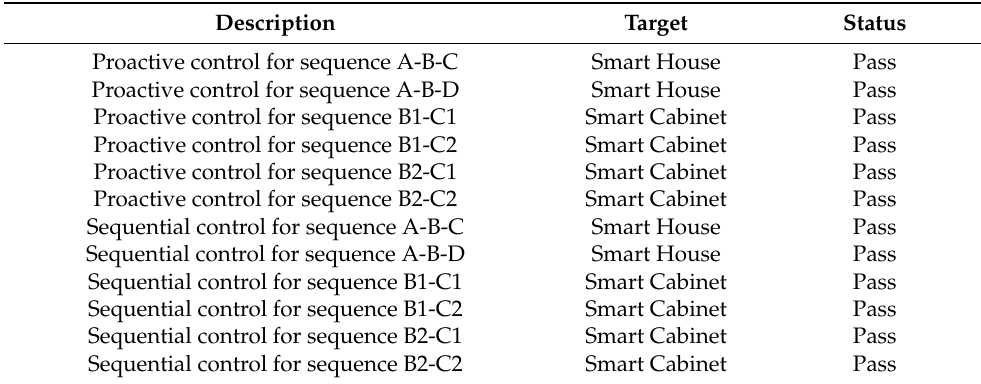
Table 3. List of test cases verifying interface between Plan4act’s FPGA controller and smart devices. KNX ® devices involved are: A-Main door; B-main lights; C-Bathroom door; D-Sliding window. IoT device: Smart Cabinet, being B1 or B2 commands for choosing upper or lower compartment, and C1 or C2 for choosing left one or right one.